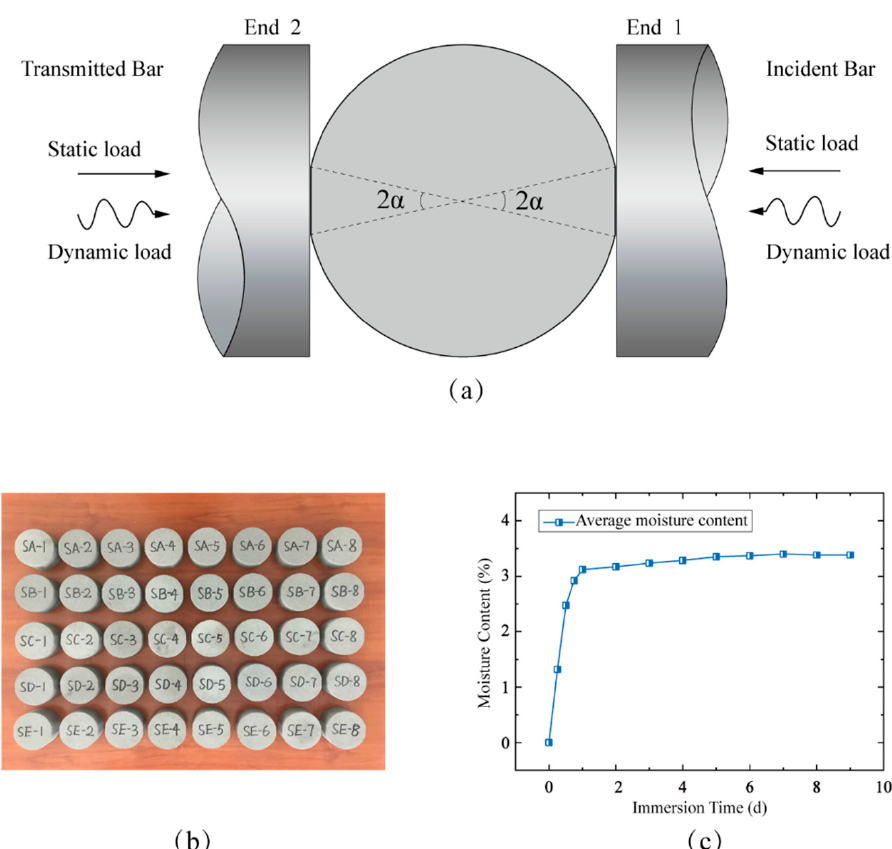
Figure 2. ( a ) Schematic of the FBD specimens under simultaneous dynamic and static loading. ( b ) Naturally saturated FBD specimens employed in our tests. ( c ) Curve of average moisture content in FBD specimens versus immersion time.